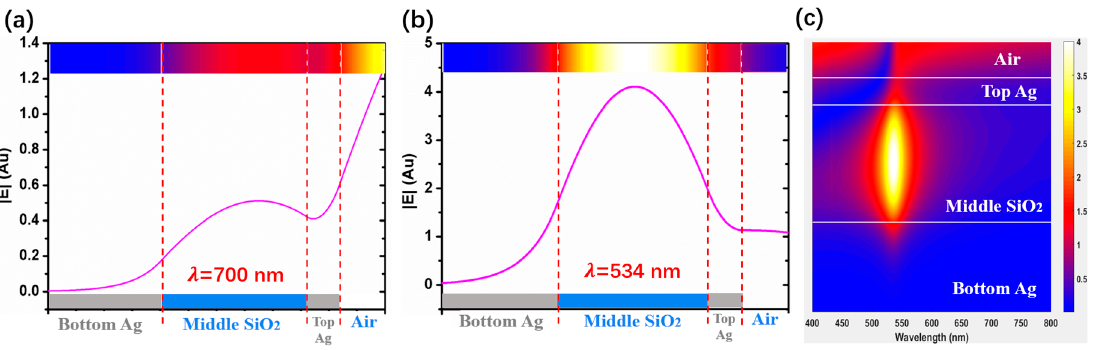
Figure 4. ( a , b ) Simulated E-field intensity distributions by the FDTD algorithm at the resonance wavelength of 534 nm and non-resonance wavelength of 700 nm, respectively. The three layers of the MDM absorber consist of a 30 nm top Ag layer, a 130 nm middle SiO 2 layer, and a 100 nm bottom Ag layer. ( c ) Simulated E-field distributions as a function of wavelength in the visible region.